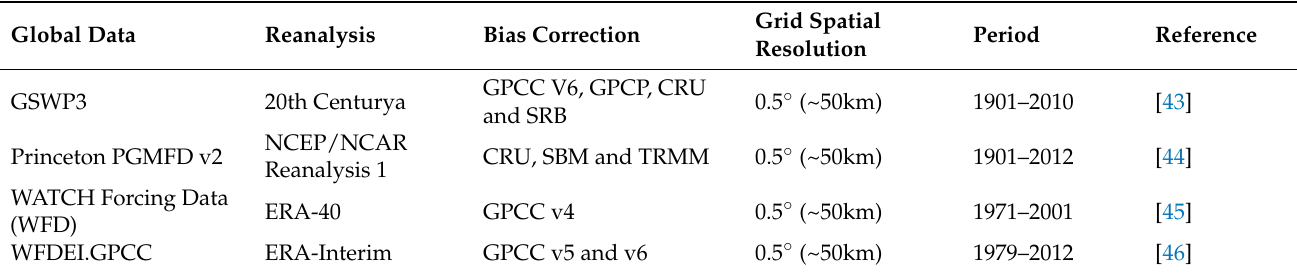
Table 1. Description of the four meteorological datasets used to drive the gHMs. These datasets are distributed by the ISIMIP within the 2a phase.